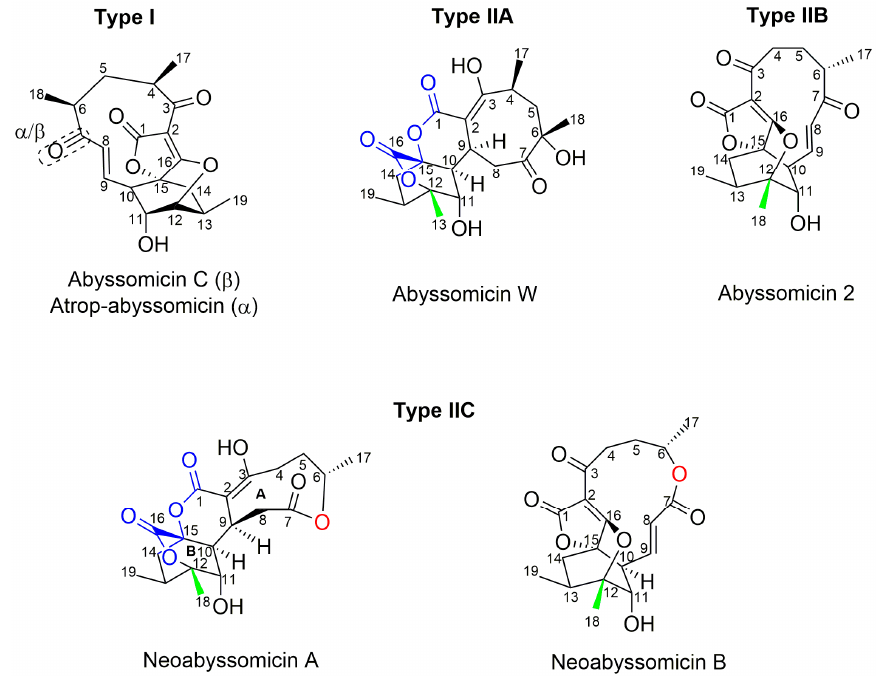
Figure 4. Representative chemical structures of each type and subtype of the abyssomicin class of natural products: type I (abyssomicin C and atrop-abyssomicin C), type IIA (abyssomicin W), type IIB (abyssomicin 2), and type IIC (neoabyssomicin A and B) (modified from [51]).